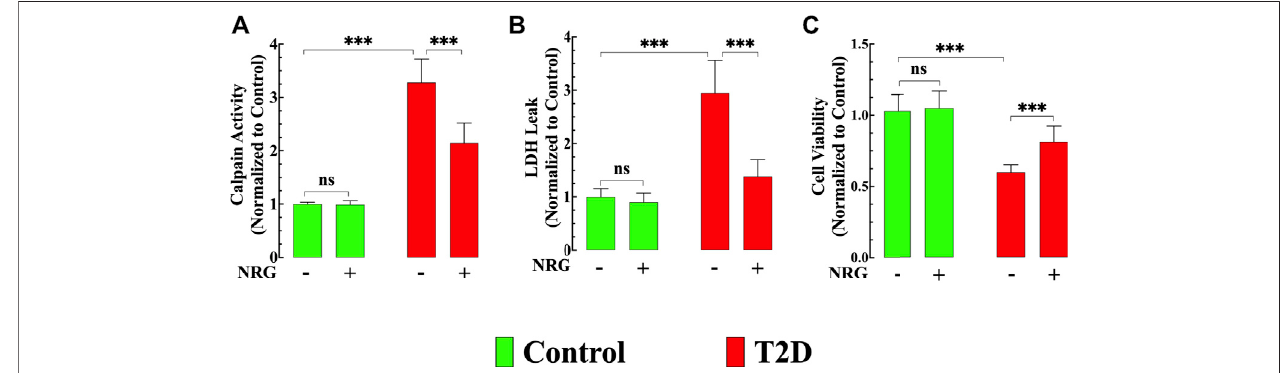
FIGURE5| Effectsofnaringinoncalpainactivity,cardiacinjury,andcellviability. (A) Calpainactivitywassigni fi cantlyincreasedinT2Dcardiomyocytescomparedto controlcardiomyocytes ( p < 0.001). Naringintreatmentsigni fi cantlyreducedcalpain activitycomparedtountreated T2Dcardiomyocytes( p < 0.001).Naringintreatment did not affect basal calpain activity in control cardiomyocytes ( p (cid:1) 0.99 compared to untreated). Calpain data was obtained from n mice (cid:1) 5/group; n cells (cid:1) 15 – 20/group. (B) LDH leak was signi fi cantly higher in T2D cardiomyocytes compared to control cardiomyocytes ( p < 0.001). Naringin treatment signi fi cantly diminished the LDH leak compared to untreated T2D cardiomyocytes. Naringin did not modify basal LDH leak in control cardiomyocytes ( p (cid:1) 0.81 compared to untreated). LDH measurements were obtained from n mice (cid:1) 5/group; n cells (cid:1) 17 – 20/group. (C) T2D cardiomyocytes ’ viability was signi fi cantly less than in control cardiomyocytes ( p < 0.001). Naringin treatment increased T2D cardiomyocytes ’ viability compared to naringin-untreated cardiomyocytes ( p < 0.001). Cardiomyocyte viability was not signi fi cantly different in the naringin group compared to the naringin-untreated control group ( p (cid:1) 0.91 compared to untreated). Data for cell viability was obtained